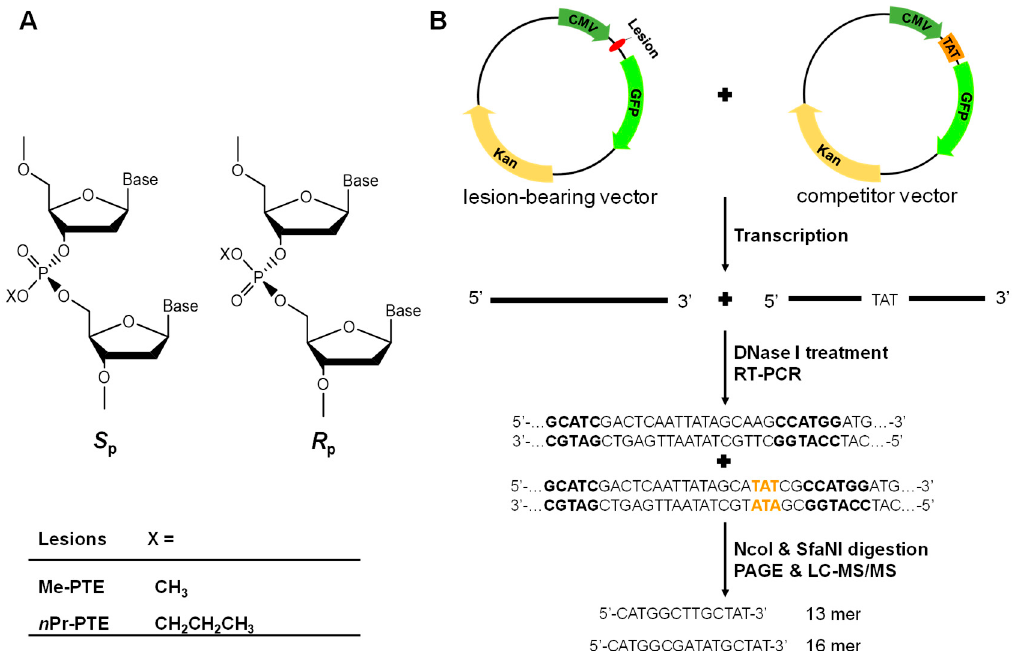
Figure 1. Schematic diagrams depicting the S P and R P diastereomers of Me-phosphotriester (PTE) and n Pr-PTE lesions in DNA ( A ) and the CTAB assay system ( B